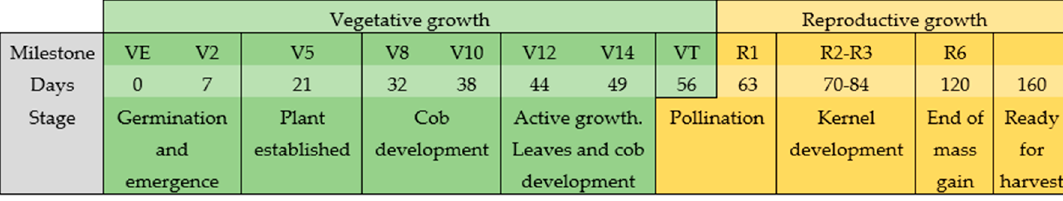
Figure 28. Maize growth stages [36].